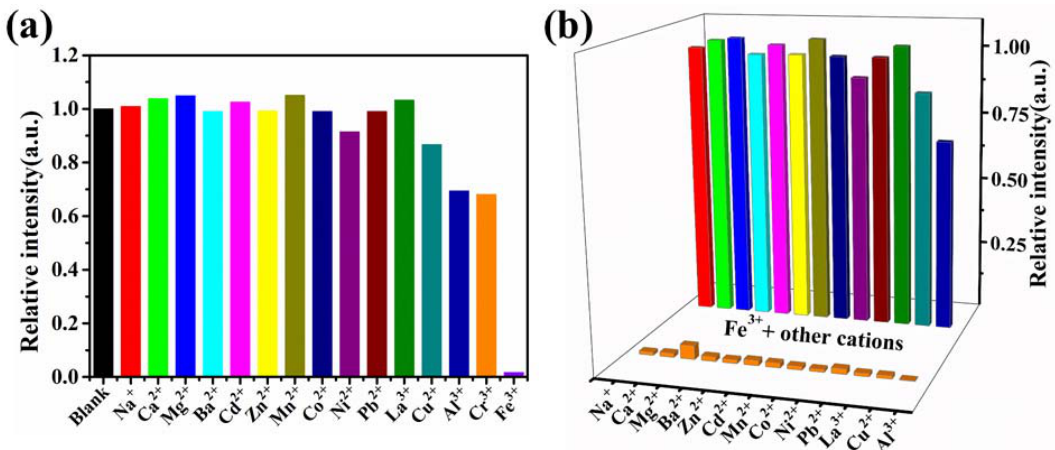
Figure 4. ( a ) The relative luminescence intensity of CdBPTC/DMF suspensions at room temperature after adding different metal ions, λ ex = 337 nm; ( b ) relative fluorescence intensity of CdBPTC + M n+ and CdBPTC + M n+ + Fe 3+ at 427 nm ( λ ex = 337 nm, M was Na + , Ca 2+ , Mg 2+ , Ba 2+ , Cd 2+ , Zn 2+ , Mn 2+ , Co 2+ , Ni 2+ , Pb 2+ , Cu 2+ , La 3+ , Al 3+ , and Fe 3+ , respectively).